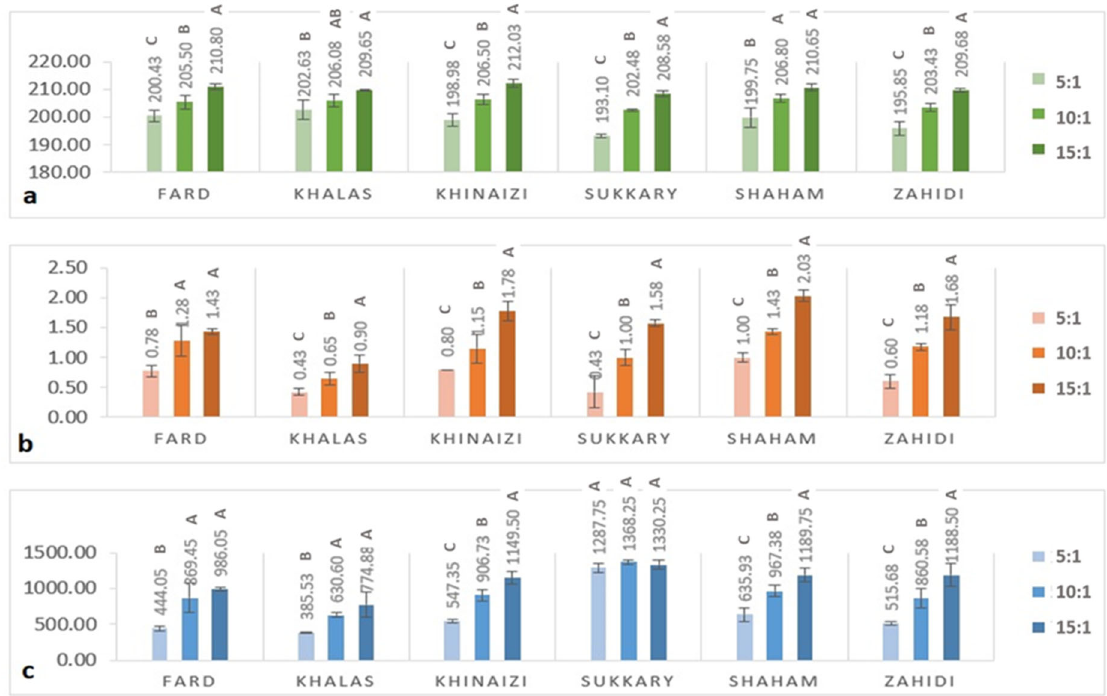
Figure 2. ( a ) DPPH radical scavenging activity ( μ g Trolox equivalent / g sample); ( b ) ABTS radical scavenging (% Scavenging effect with ABTS/mg) %; ( c ) Ferric reducing assay, ( μ g equivalent Trolox / g) of six varieties of date seed powder extracted at three sample to solvent ratios (5:1, 10:1, and 15:1). Different uppercase superscript letters in a variety denote significant differences, p <